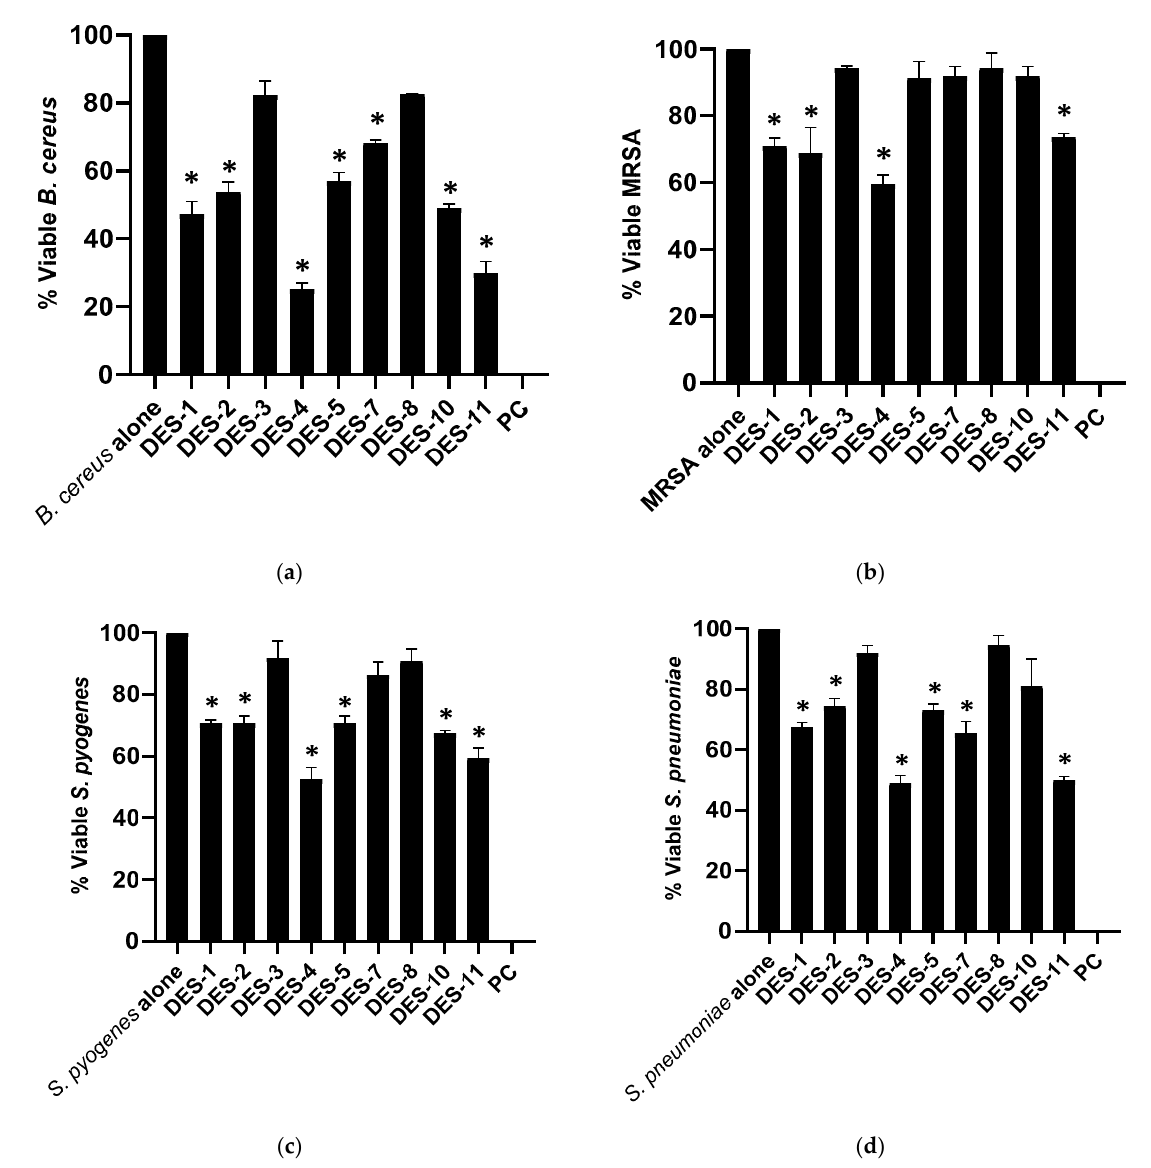
Figure 3. Antibacterial properties of DES against Gram-positive bacteria. ( a ) represents bactericidal effects against B. cereus , ( b ) represents bactericidal activity against MRSA, ( c ) against S. pyogenes , and ( d ) against S. pneumoniae . The data are articulated as the means ± standard errors from three independent trials carried out in duplicate. (*) signifies p ≤ 0.05. Table 3. 50% minimum inhibitory concentration (MIC 50 ) of deep eutectic solvents against bacteria (µL). Deep Eutectic Solvent